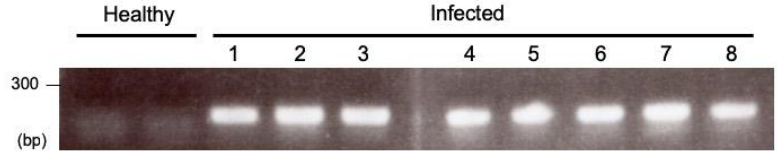
Figure 1. Reverse transcription polymerase chain reaction (RT-PCR) detection of Apple latent spherical virus (ALSV) from the upper leaves of Silene latifolia plants at 21 days post-inoculation (dpi). Lane 1–4, one-shot inoculation was applied to the plants; lane 5–8, two-shot inoculation to the plants. Two healthy plants were used as uninfected healthy controls.